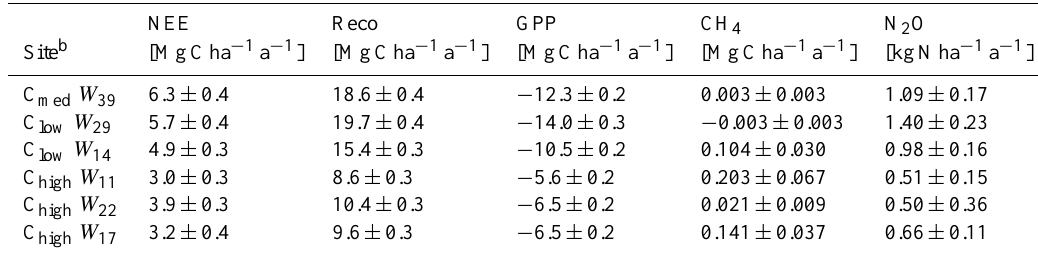
Table 3. Annual fluxes of NEE, Reco and GPP, CH 4 and N 2 O (1 June 2011 to 1 June 2012; annual flux ± uncertainty a ).